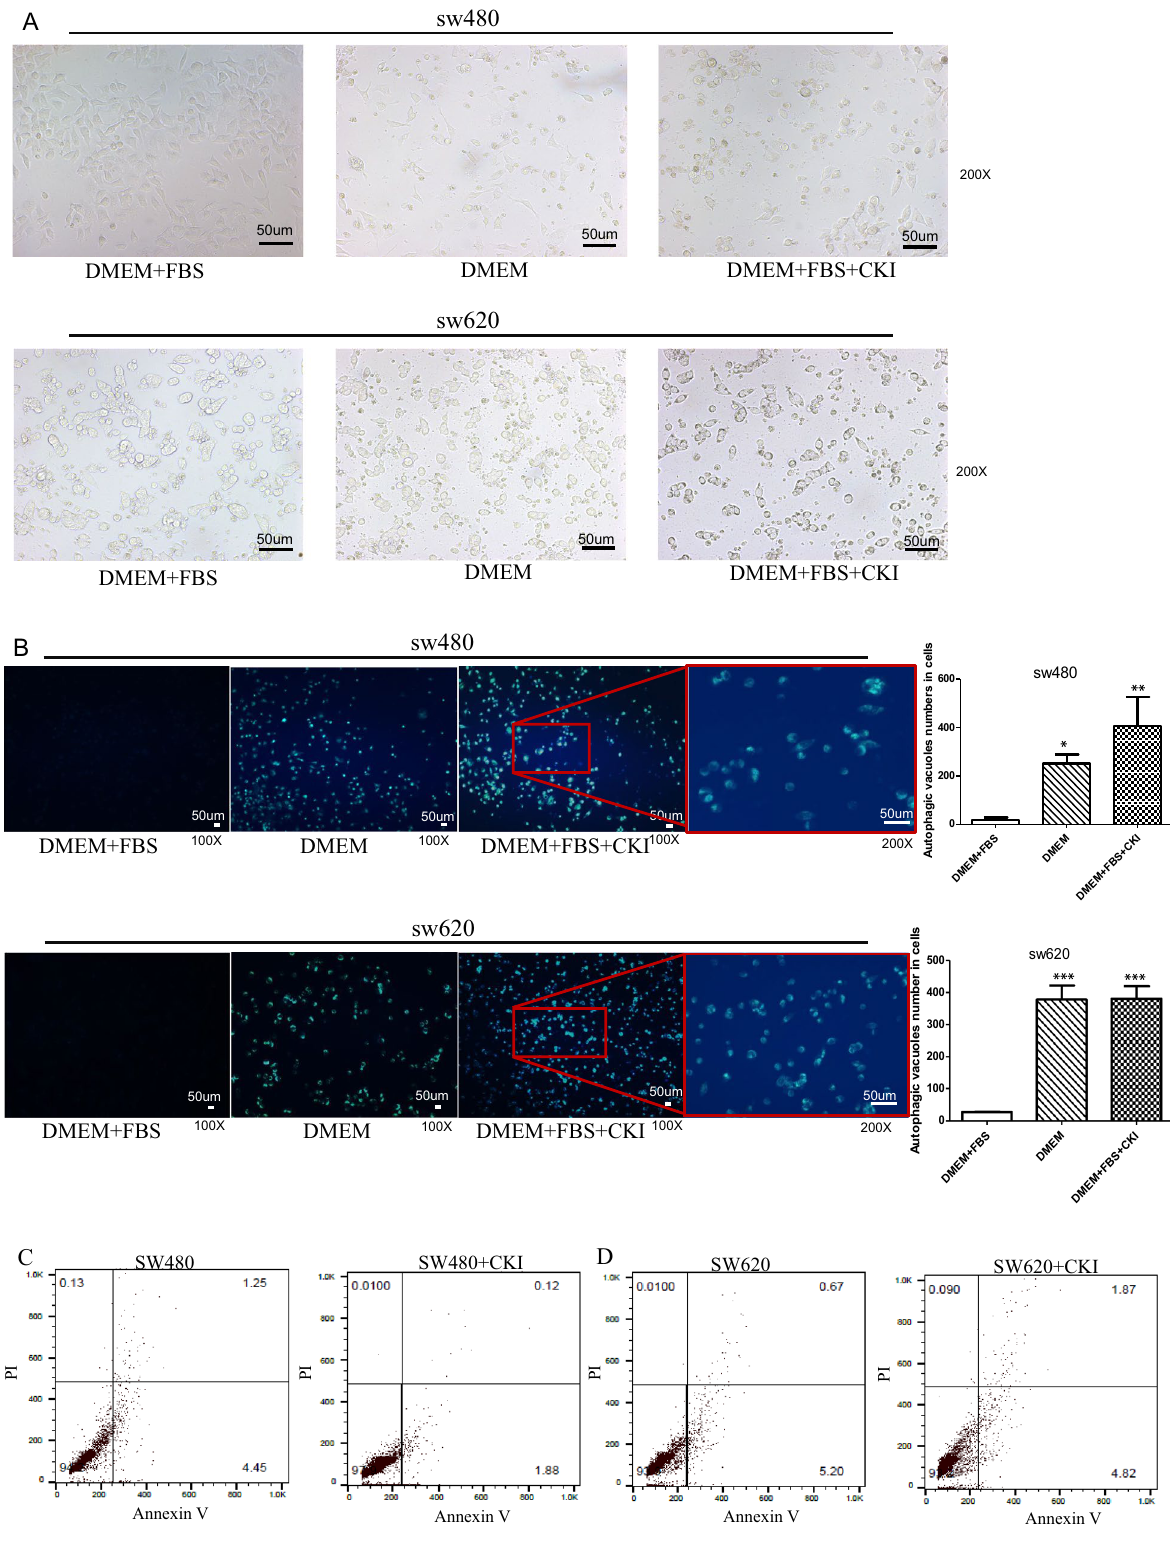
Figure 6. Compound Kushen injection induces autophagy but does not alter the apoptosis of SW480 and SW620 CRC cells in vitro. SW480 and SW620 cells were incubated in regular DMEM as a negative control and in serum-depleted medium as a positive control for 24 h. Both control cells and CKI-treated cells were incubated with a working solution of Autophagy Blue for 30 min at 37 °C in a 5% CO 2 incubator and then washed four times with wash buffer. ( A ) Cells were imaged under white light under a microscope. ( B ) Cells were imaged under a fluorescence microscope with a DAPI channel. Autophagy is indicated by the bright blue dot staining of autophagic vacuoles. Each data point represents the mean ± SD from three independent experiments. *** p < 0.001, compared with negative control. The scale bar represents a length of 50 um in each of the images and the image was created using GraphPad Prism 5.01 software. ( C , D ) Cell apoptosis was assessed by the Annexin-V